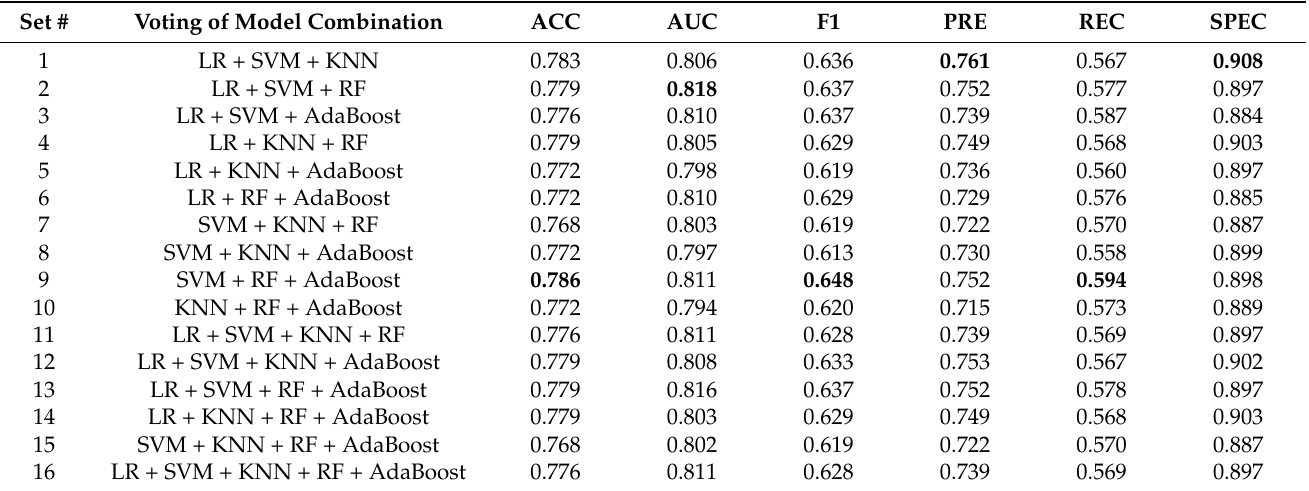
Table 10. Computational results for CGGA dataset with LASSO feature selection method and ensemble learning models.